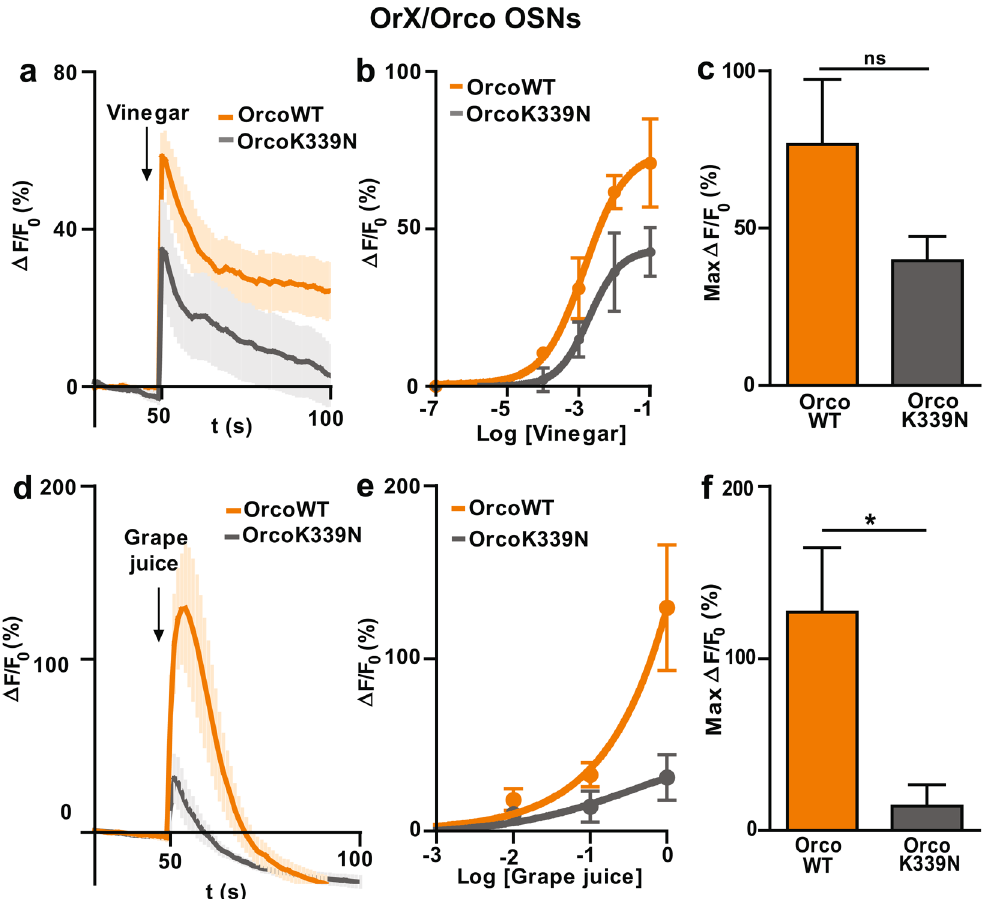
Figure 3. Effect of Orco CBS mutation on the odor response in OrX/Orco expressing OSNs using vinegar and grape juice as stimulus. (a) Time course of Ca 2+ fluorescence responses obtained in OrX/OrcoWT OSNs and OrX/OrcoK339N OSNs upon OR stimulation with 10 –2 concentration of vinegar (n = 5 for OrcoWT, n = 5 for OrcoK339N). (b) Concentration response relationship for OrcoWT and OrcoK339N OSNs (n = 5). (c) Maximum Ca 2+ fluorescence response (Max ∆F/F 0 (%)) obtained by subtracting the base level at 50 s from the maximum Ca 2+ fluorescence at 10 –1 dilution. (d) Time course of Ca 2+ fluorescence responses obtained in OrcoWT and OrcoK339N flies upon OR stimulation with pure grape juice (n = 5 for OrcoWT, n = 5 for OrcoK339N). (e) Concentration response relationship for OrcoWT and OrcoK339N OSNs (n = 5). (f) Maximum Ca 2+ fluorescence response (Max ∆F/F 0 (%)) obtained by subtracting the base level at 50 s from the maximum Ca 2+ fluorescence obtained for pure grape juice. n = number of antennae. Two-tailed unpaired t- test , * P < 0.05, ns = not significant. Data given as mean ±